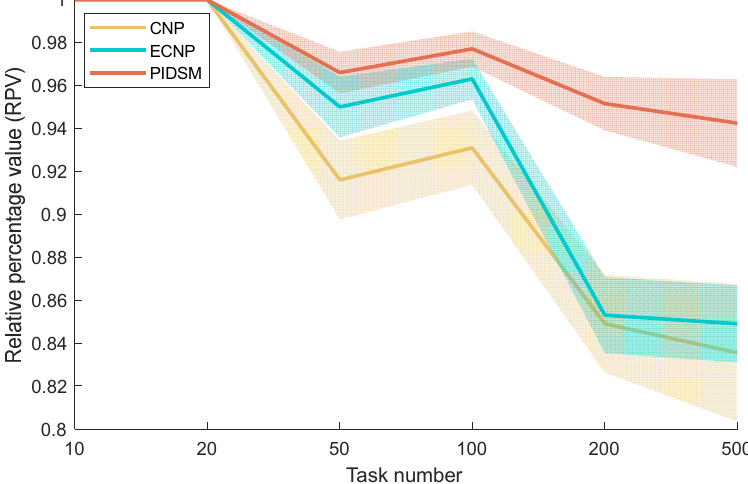
Figure 7. The impact of the variation of target number on the performance of algorithms.